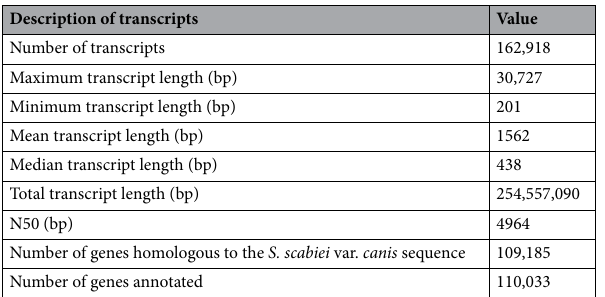
Table 1. Statistics of the transcriptomic analysis for Sarcoptes scabiei var. nyctereutis collected from wild Japanese raccoon dogs.